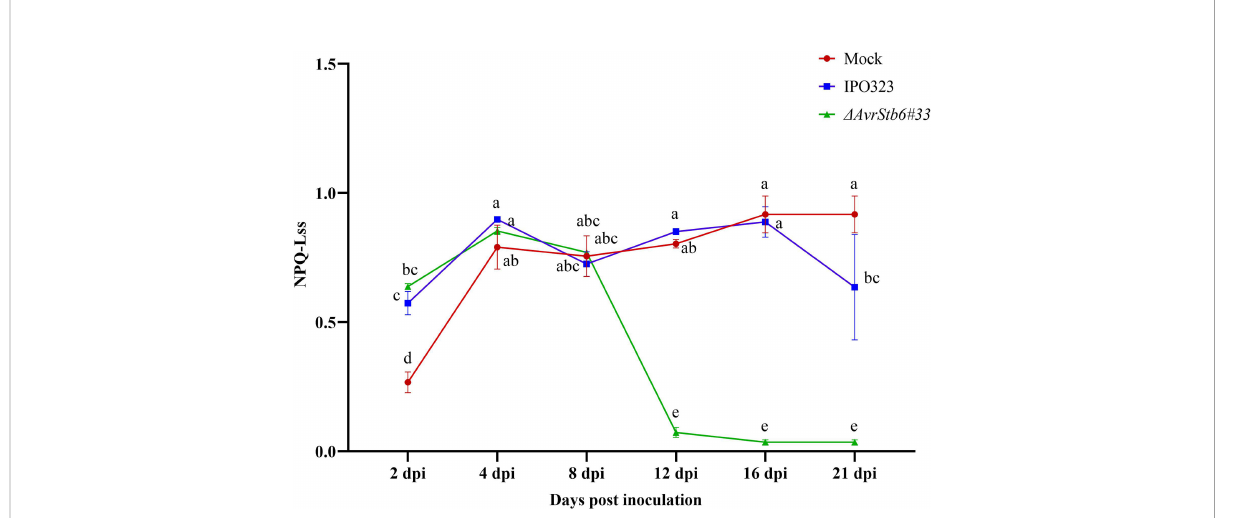
FIGURE 4 AvrStb6-Stb6 interaction leads to high non-photochemical quenching (NPQ). The leaves of cv. Sha fi r with Stb6 was infected with either the WT IPO323 and D AvrStb6#33 strains and NPQ was recorded at 2, 4, 8, 12, 16, and 21 days post-inoculation. Data are indicate as mean ± SD (Standard Deviation) of four biological samples from one independent experiment. Different lowercase letters indicate statistically signi fi cant differences (P ≤